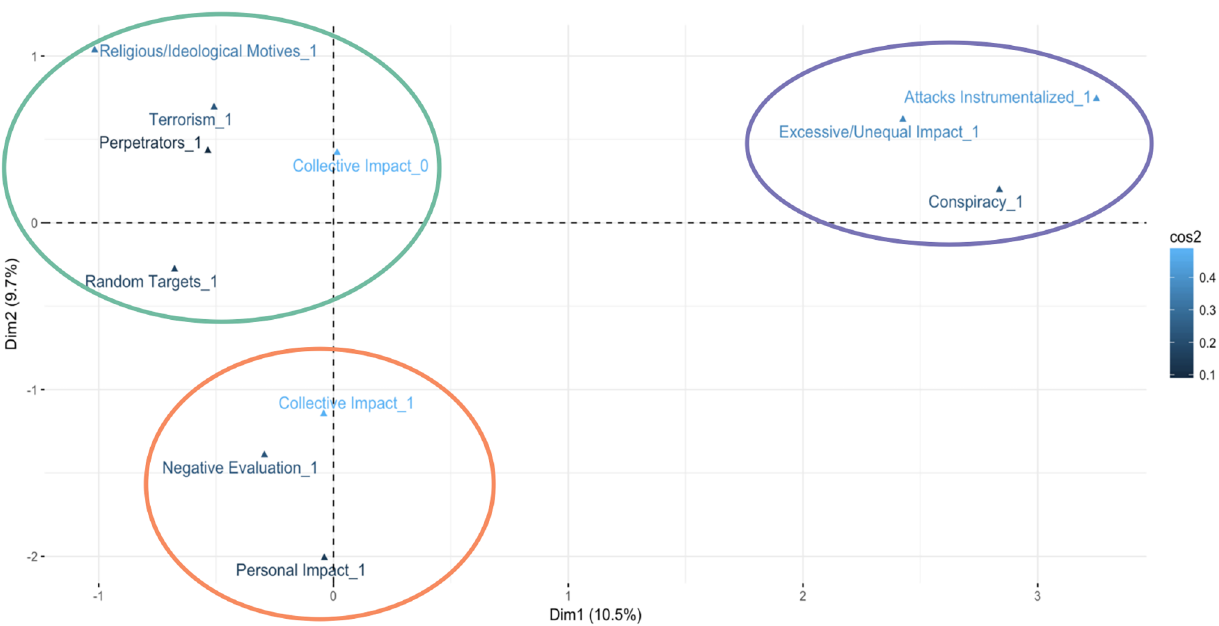
Figure 1. Dimensional space extracted by a multiple correspondence analysis showing the most representative comparison categories used to compare the 2015 Paris attacks and the 11 September 2001 attacks. Note. The labels of the comparison categories are colored based on their quality of representation (cos 2 ) on the dimensional plane, with lighter blue representing a higher quality of representation compared to the deeper shade of blue, as represented by the color gradient on the right. The circles correspond to the three clusters that emerge after analyzing the comparison categories most associated with the opposite poles of each dimension (i.e., the two